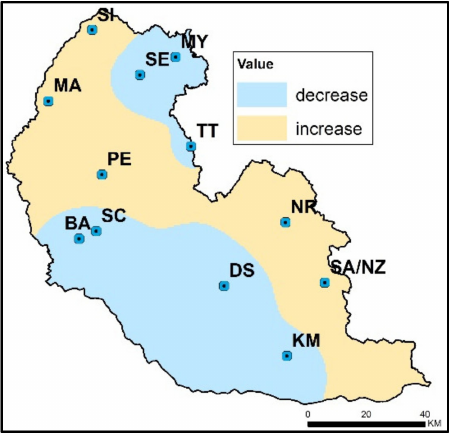
Figure 5. Differences in Umax mean compared to last decade.